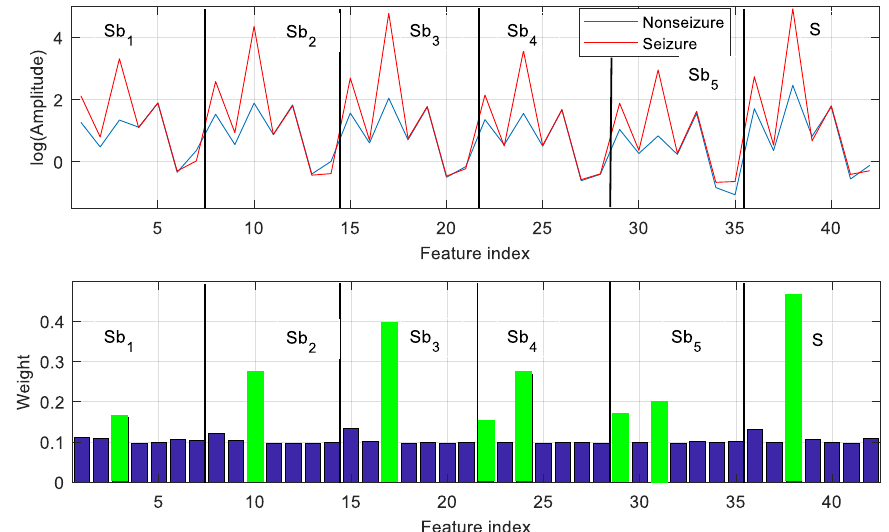
Figure 5. Features and corresponding weights assigned for feature selection. Top panel: feature vectors of length 42 obtained from nonseizure (set A) and seizure (set E) EEG frames. Bottom panel: weight vector derived by the GED approach for feature selection. Each feature is assigned a weight .